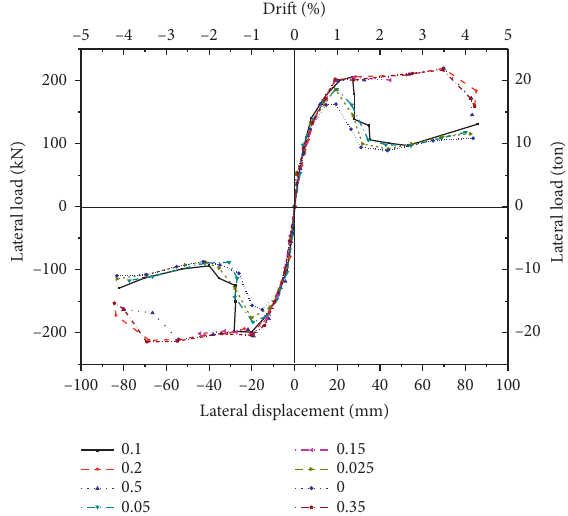
Figure 14: Load-displacement predictions under different axial loading levels (specimen